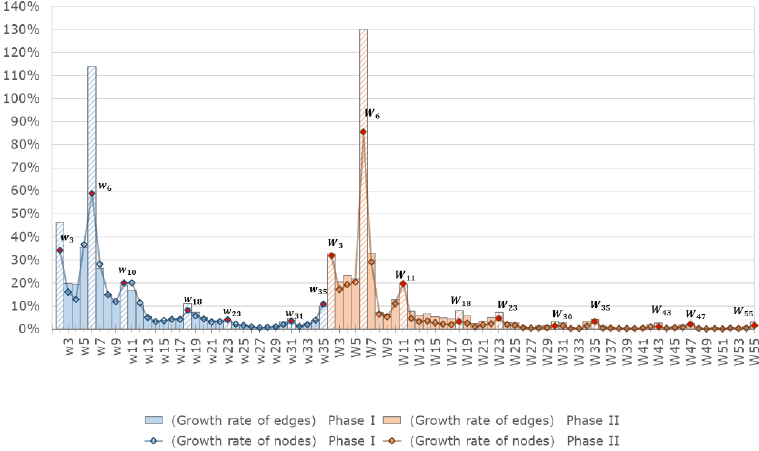
Figure 3. The growth rate of nodes and edges. Note: in the oriental axis, 𝑤 𝑖 and 𝑊 𝑖 are the labels for the time windows of Phase I and Phase II,